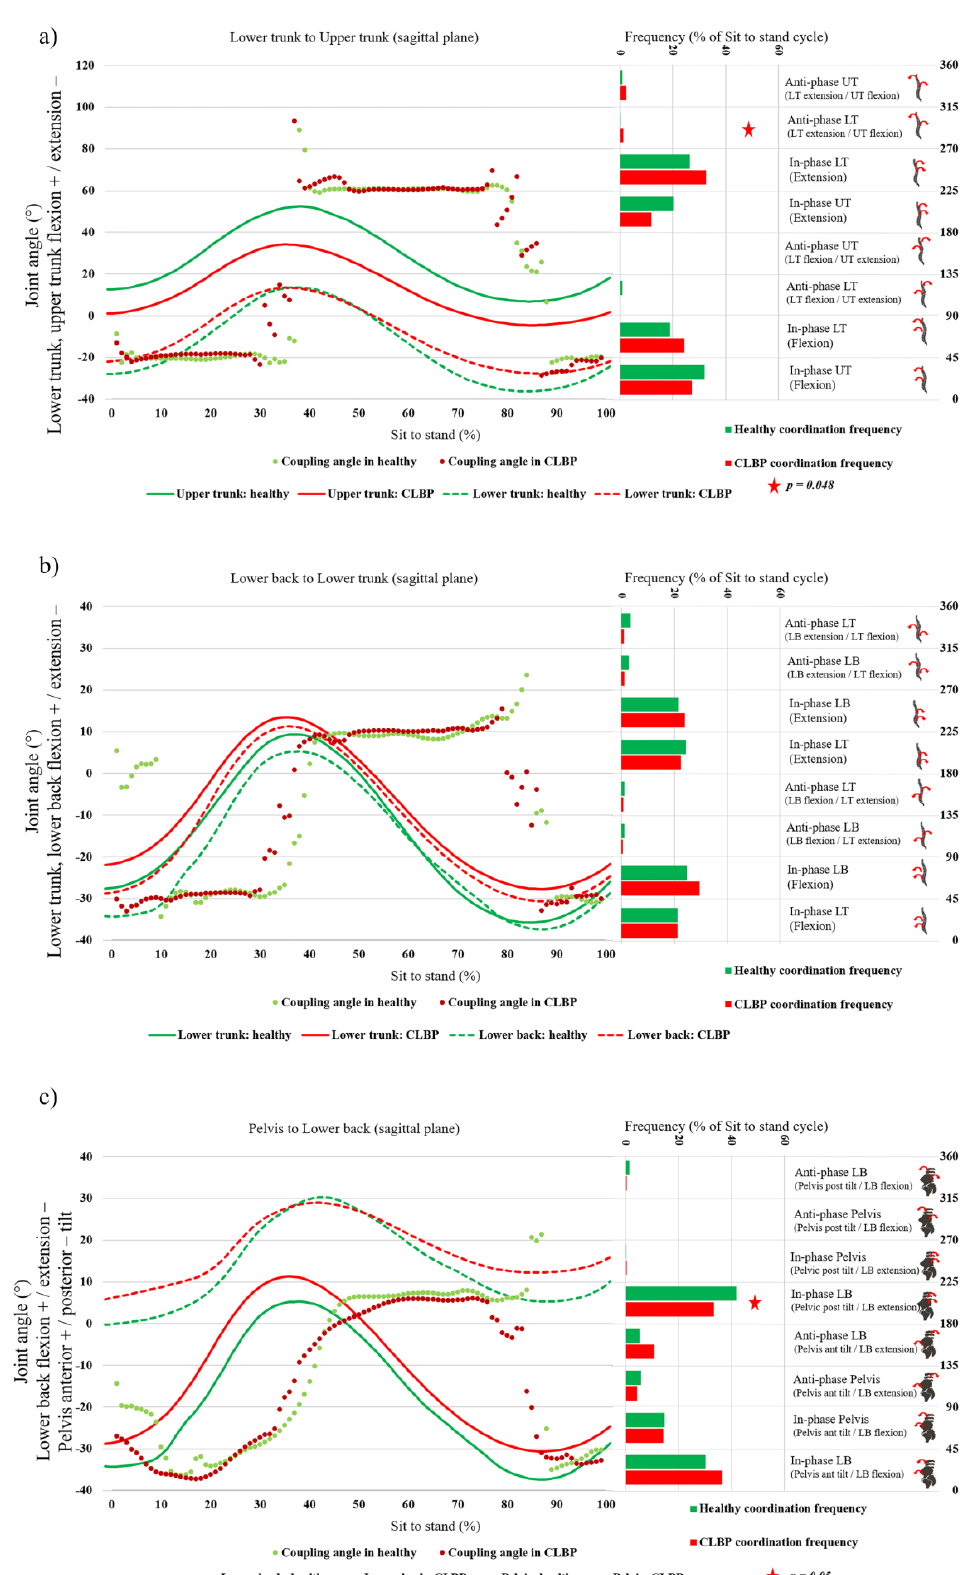
Figure 3. ( a ) LT/UT, ( b ) LB/LT, and ( c ) pelvis/LB segments angular displacement diagram in the sagittal plane, and the results of the coupling angle frequency during